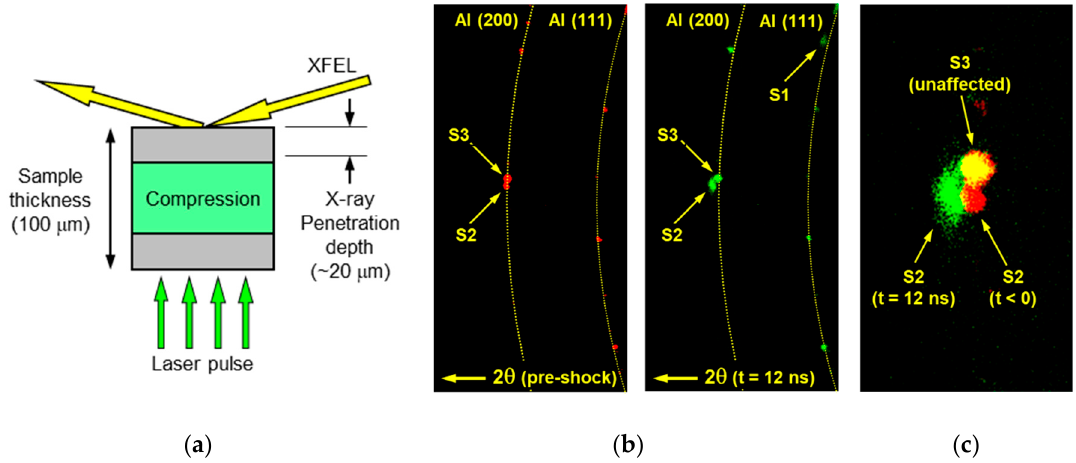
Figure 18. Diffracted XFEL patterns of the solution heat-treated A6061 aluminum alloy at 12 ns after laser pulse irradiation: ( a ) The position of the stress wave; ( b ) Diffraction patterns before and after laser irradiation; ( c ) Superimposition of diffraction spots “S2” and “S3”.